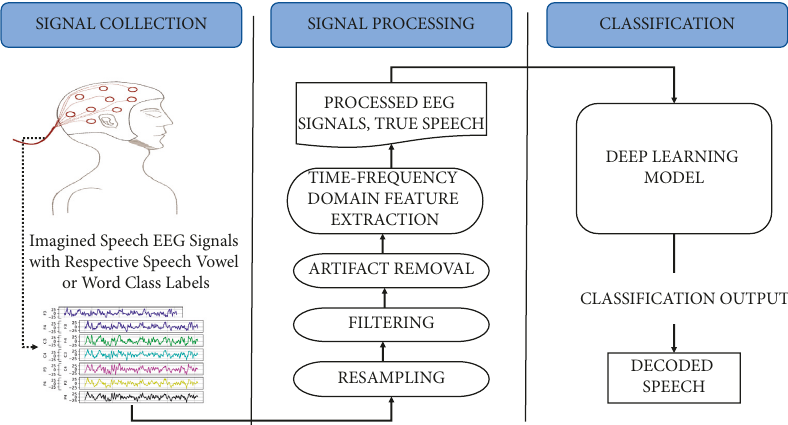
Figure 1: The architecture of an EEG-based imagined speech BCI system.